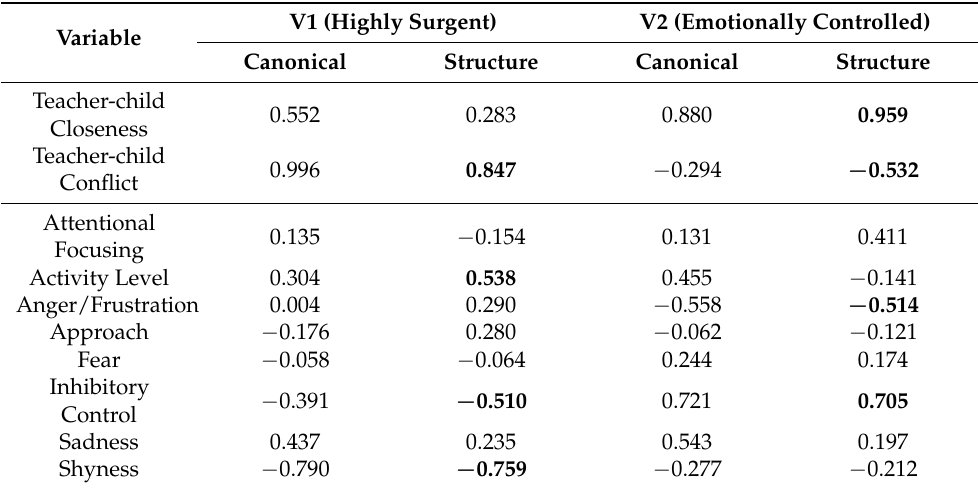
Table 3. Canonical solution for temperament predicting teacher-child relationship for variates 1 and 2. 1.